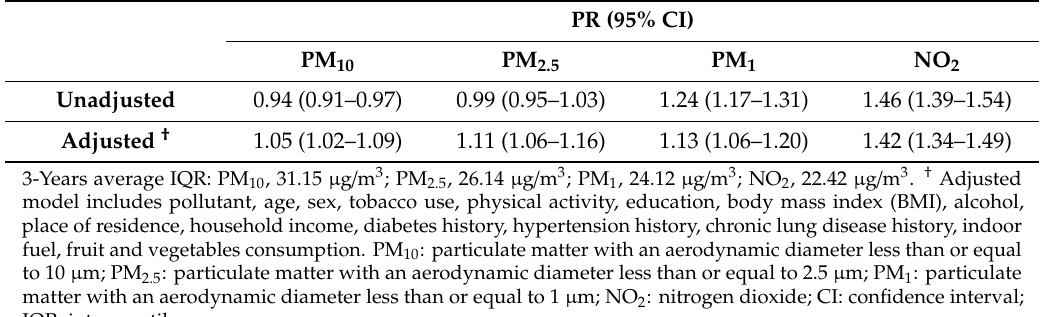
Table 3. Association between prevalence ratio of anaemia and 3-year moving average of